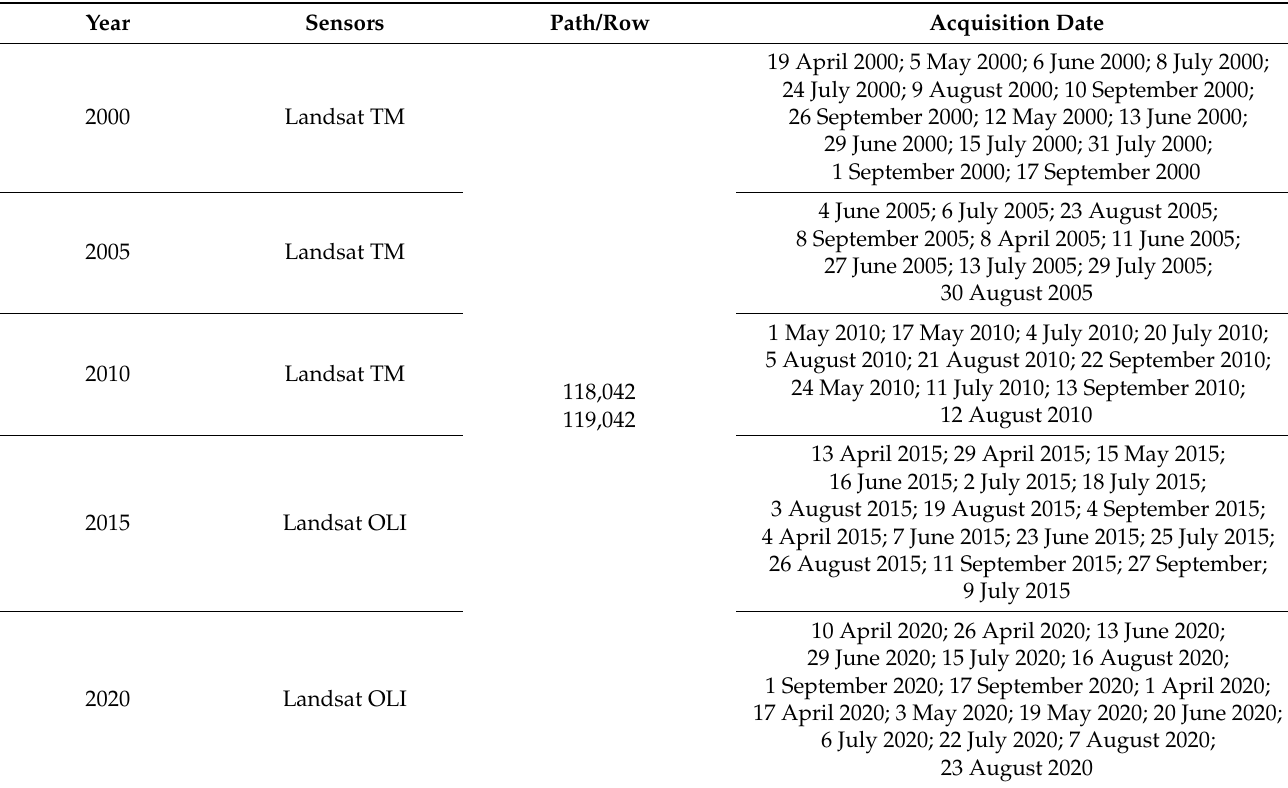
Table A1. Landsat image series data of Fuzhou from 2000 to